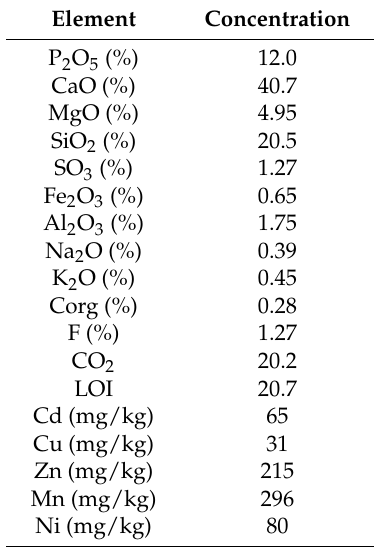
Table 2. Concentrations of major and trace elements in the studied raw phosphate.